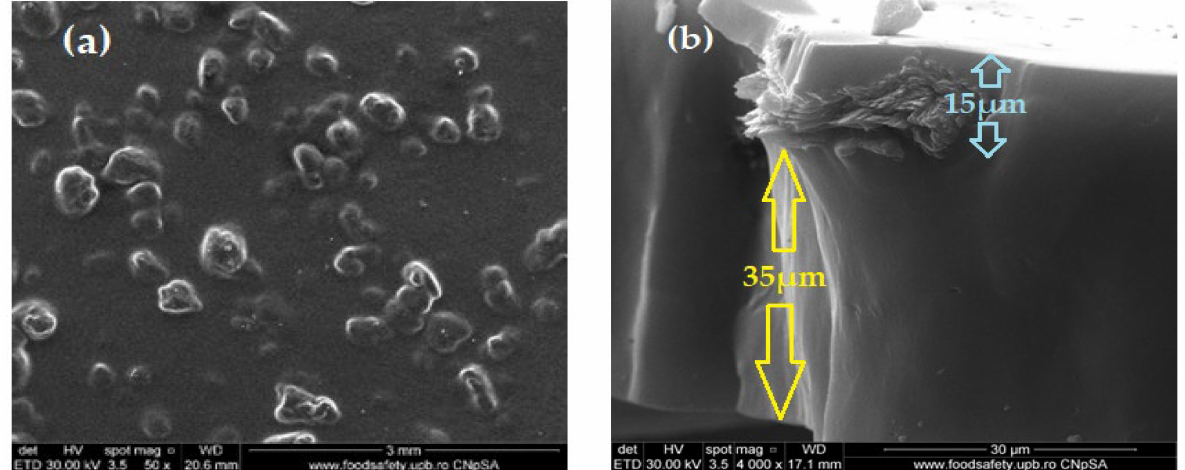
Figure 9. Scanning electron microscopy (SEM) images for the Chi/sEPDM composite membrane: top surface ( a ); and cross-section ( b